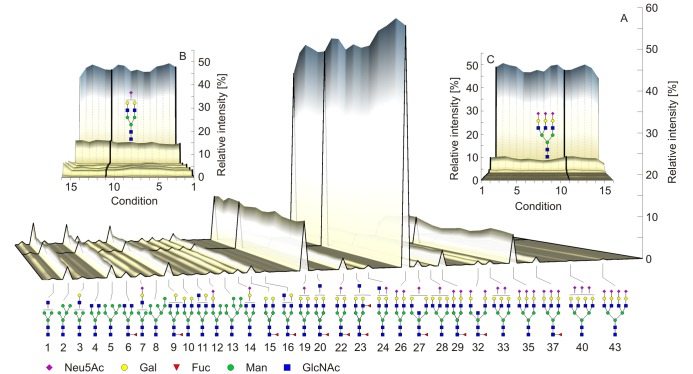
Results of MALDI-TOF-MS analysis.Average MALDI-TOF-MS N-glycan (A) relative intensities from 10 healthy donors under 16 preanalytical conditions (Fig 1). The serum and plasma standard conditions are marked with thick lines. Small increase of N-glycans having low masses (B) can be observed for hemolysed samples (condition 16), while N-glycans having high masses show a small decrease (C).